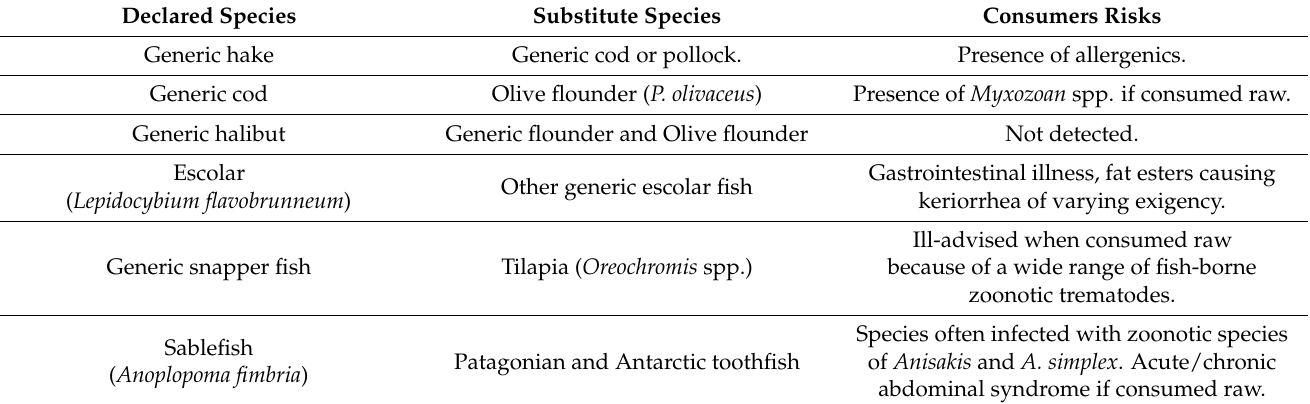
Table 1. Examples of fish substitution in the world and associated consumer